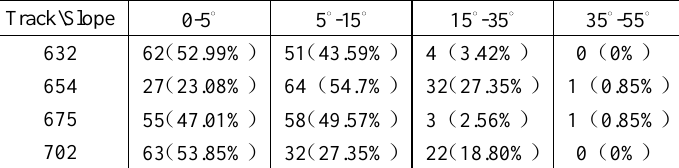
Table 4. Statistics of Laser footprints